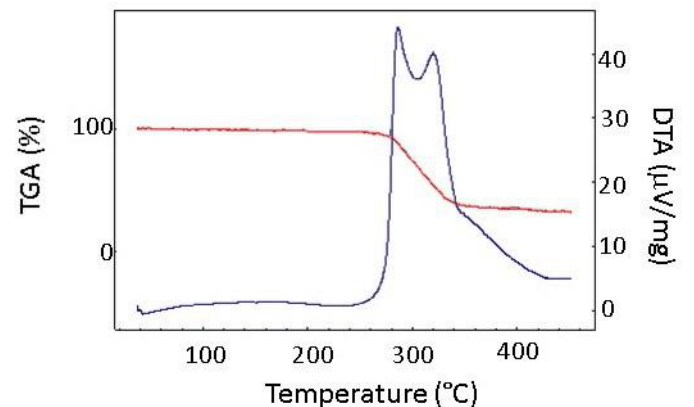
Figure 7. Typical TG DTA pattern of the studied PU foam material: red line—TGA, blue line—DTA.